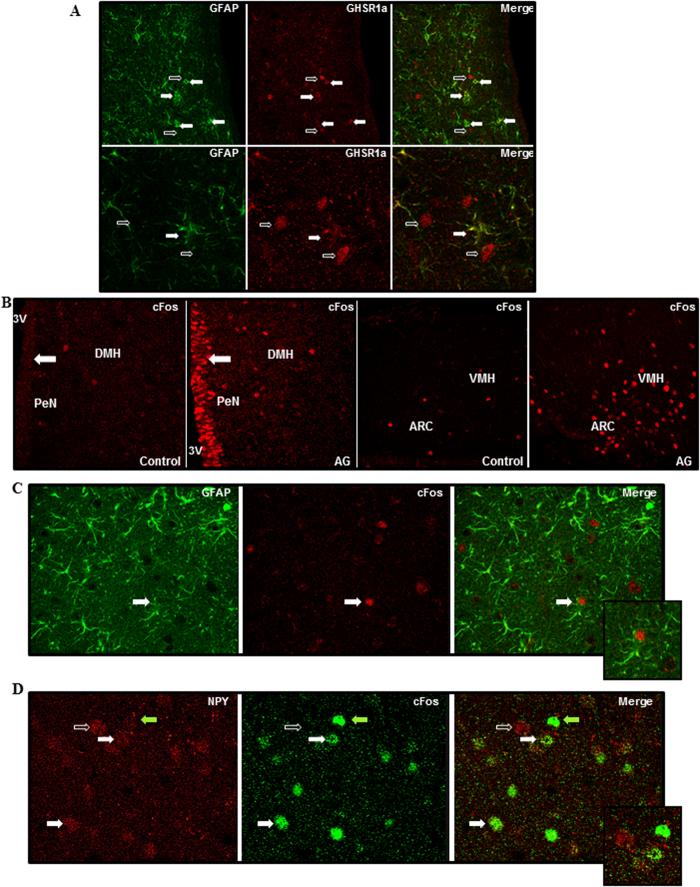
Analysis of hypothalamic glial response to intracerebroventricular acyl-ghrelin treatment.(A) Double immunohistochemistry for glial fibrillary acidic protein (GFAP; green) and ghrelin receptor (GHSR1a; red) in the hypothalamus. Solid arrows indicate cells positive for both GFAP and GHSR1a. Open arrows indicate cells that are immunopositive only for GHSR1a. (B) Immunohistochemistry for cFos in control rats and rats that were treated icv with acyl-ghrelin (AG) for 1 hour. There was a clear increase in cFos positive cells (red) in the hypothalamus and in cells lining the 3rd ventricle (3 V) after AG treatment (solid arrow). (C) Double immunohistochemistry for GFAP and cFos. Solid arrow indicates a cell that is immunopositive for both GFAP and cFos. (D) Double immunohistochemistry for neuropeptide Y (NPY) and cFos in the arcuate nucleus. Solid errors indicate double labeled cells and the open arrow indicates a NPY neuron that is not positive for cFos. The green arrow indicates a cell only positive for cFOS. ARC = arcuate nucleus, DMH = dorsomedial hypothalamus, PeN = periventricular nucleus, VMH = Ventromedial nucleus.